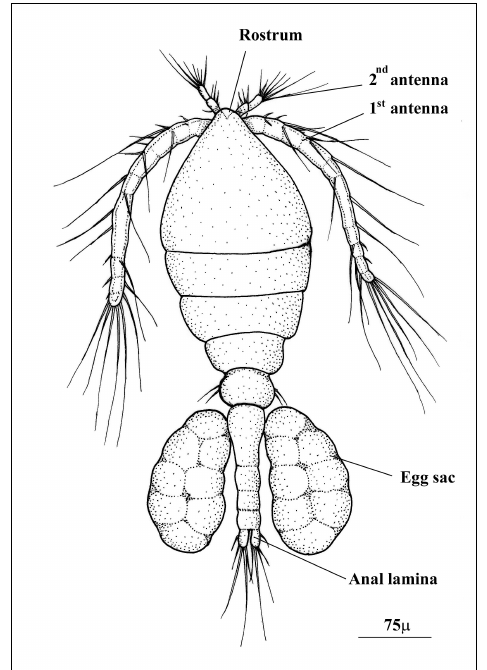
Fig. 2. Dorsal view of Oithona similis